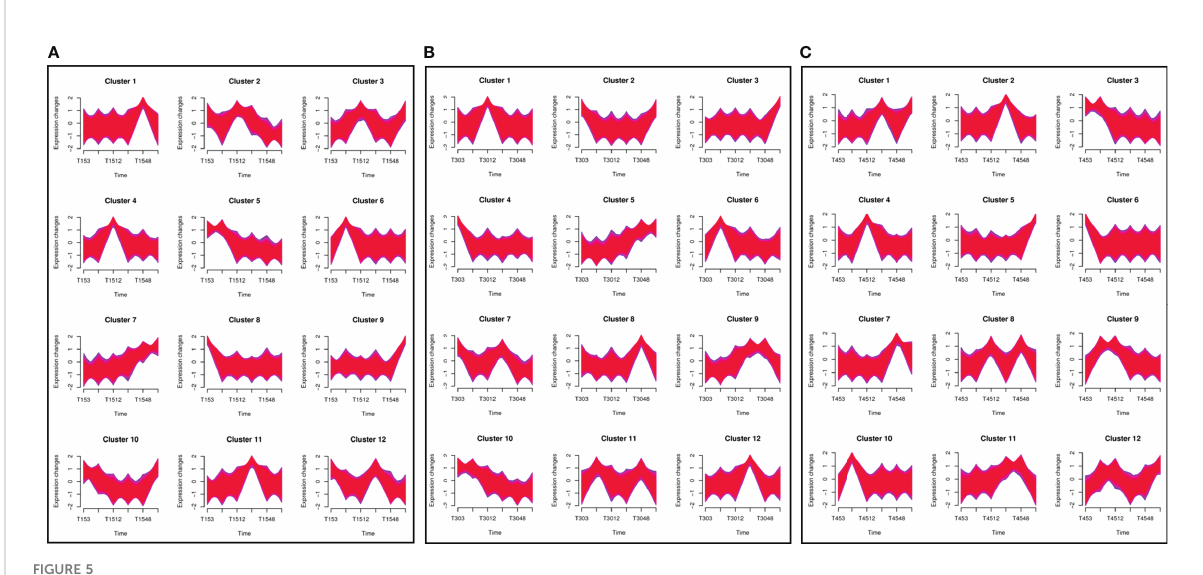
FIGURE 5 Clustering analysis of differentially expressed genes (DEGs) and time-series analysis of DEGs under different salinity conditions. A total of 108,002 unigenes were classi fi ed into 12 clusters using the Mfuzz package in R. A. The horizontal axis shows the different groups, while the vertical axis shows the time series of the gene expression levels. (A) Under a 15 PSU treatment; (B) Under a 30 PSU treatment; (C) Under a 45 PSU